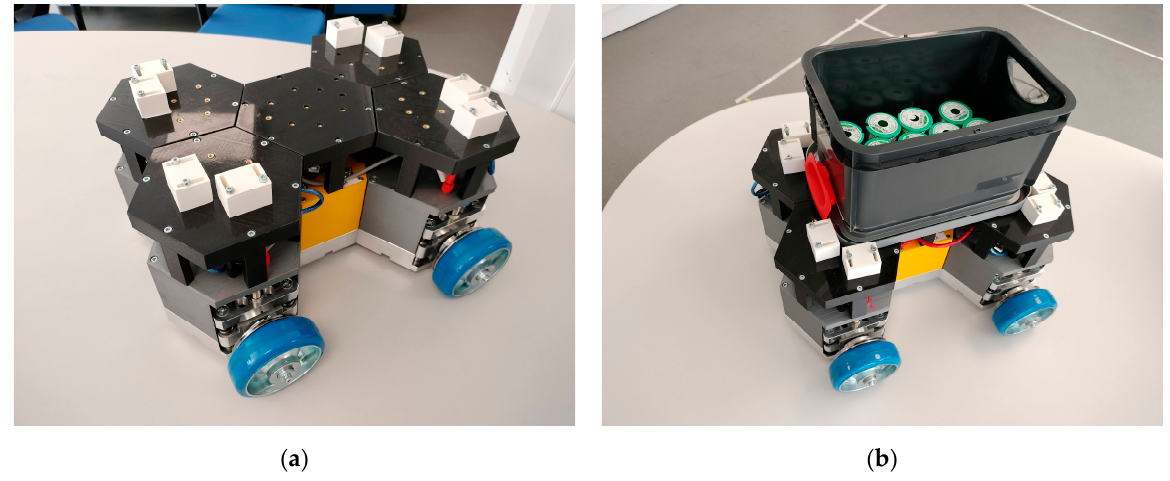
Figure 32. Modular mobile robot with conventional four wheels. ( a ) Without transport box. ( b) With load carried.